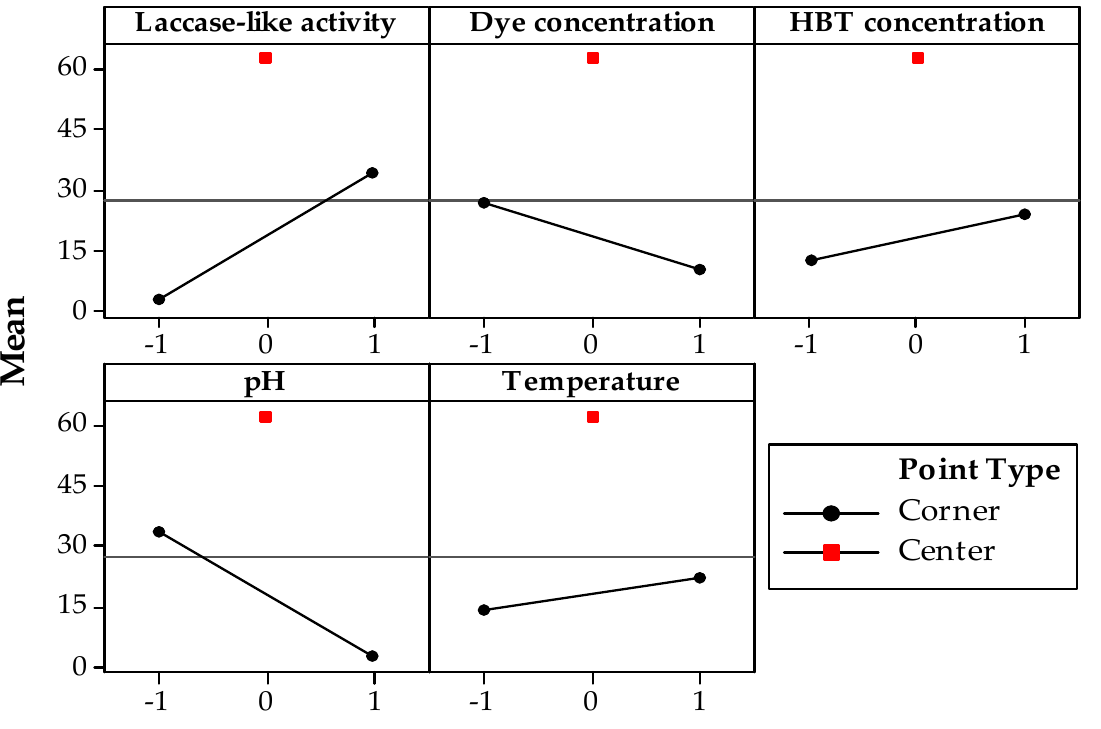
Figure 1. Main effects plot for RB5 decolorization after 120 min of reaction as function of coded value of factors. Red squares are center points and black diamonds are corner points.